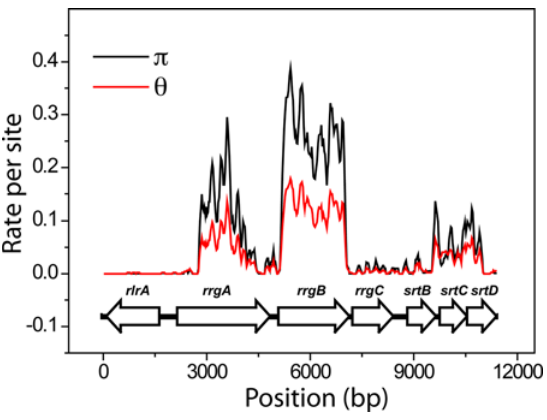
Figure 1. Genetic diversity of the pilus operon. Nucleotide diversity p and Watterson estimator h of the population mutation rate per site measured along the sequence. The positions of the ORFs on the sequence are also shown.